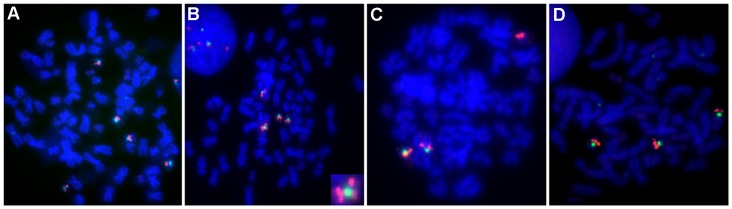
Metaphases of CRC cell lines with TOP1 gene copy number increases.A: Colo-205, B: HT-29 (lower right corner: digitally enlarged isochromosome), C: KM12, D: SW620. Note: Due to the existence of two chromatids in each metaphase chromosome, the observed number of gene signals is double that of what is observed in an interphase nucleus.